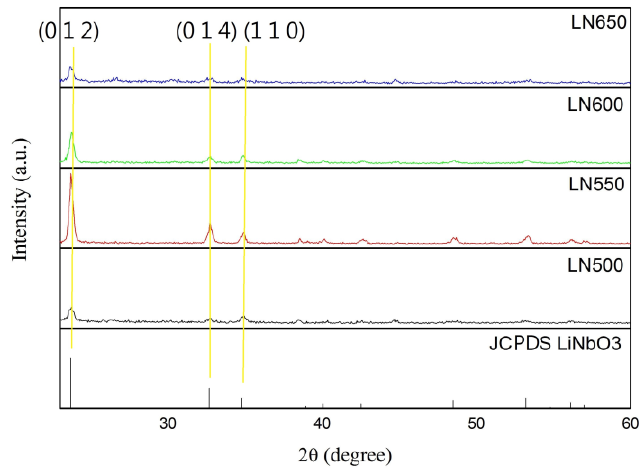
Figure 5. Merge four groups of LiNbO 3 thin film at different annealing temperature with LiNbO 3 Joint Committee on Powder Diffraction Standard (JCPDS).